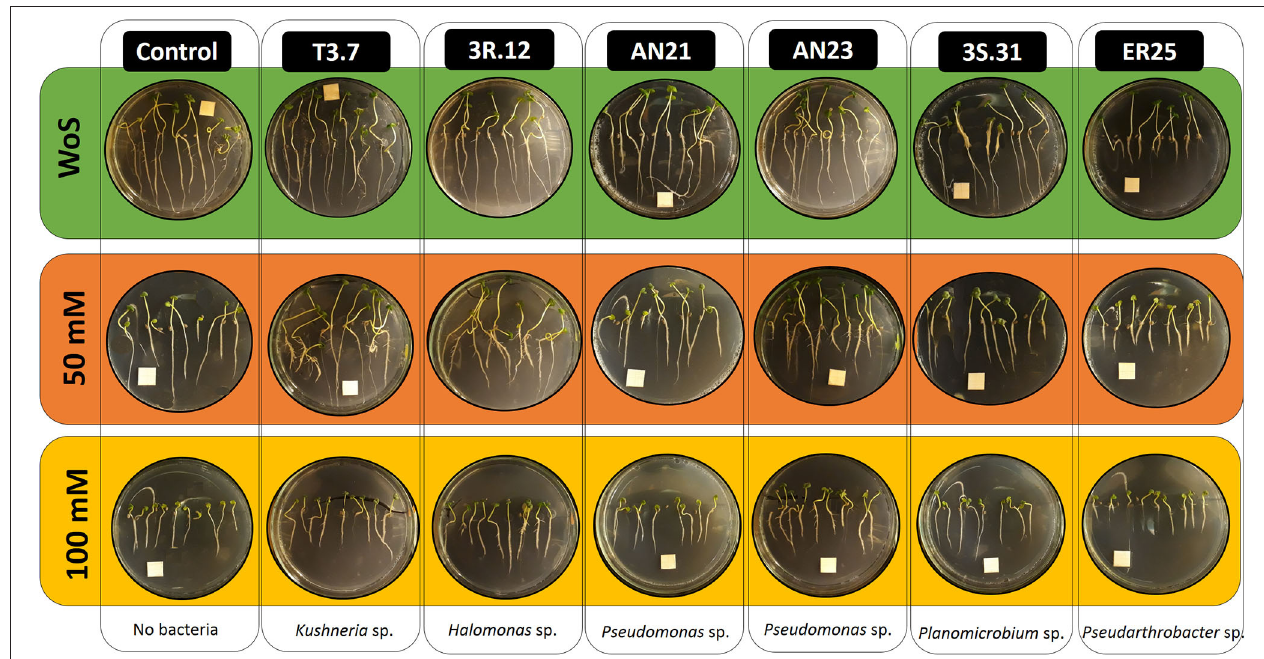
FIGURE 4 | Photographs of seedlings grown vertically on agar plates containing an MS/2 medium 7 days after seed plating. White squares in the Petri dishes are 1 cm 2